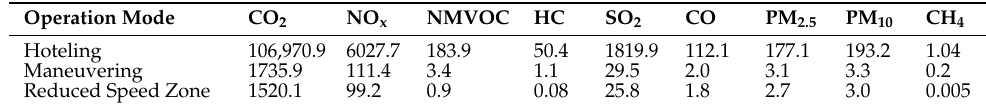
Table 4. Ship emissions of different operational modes